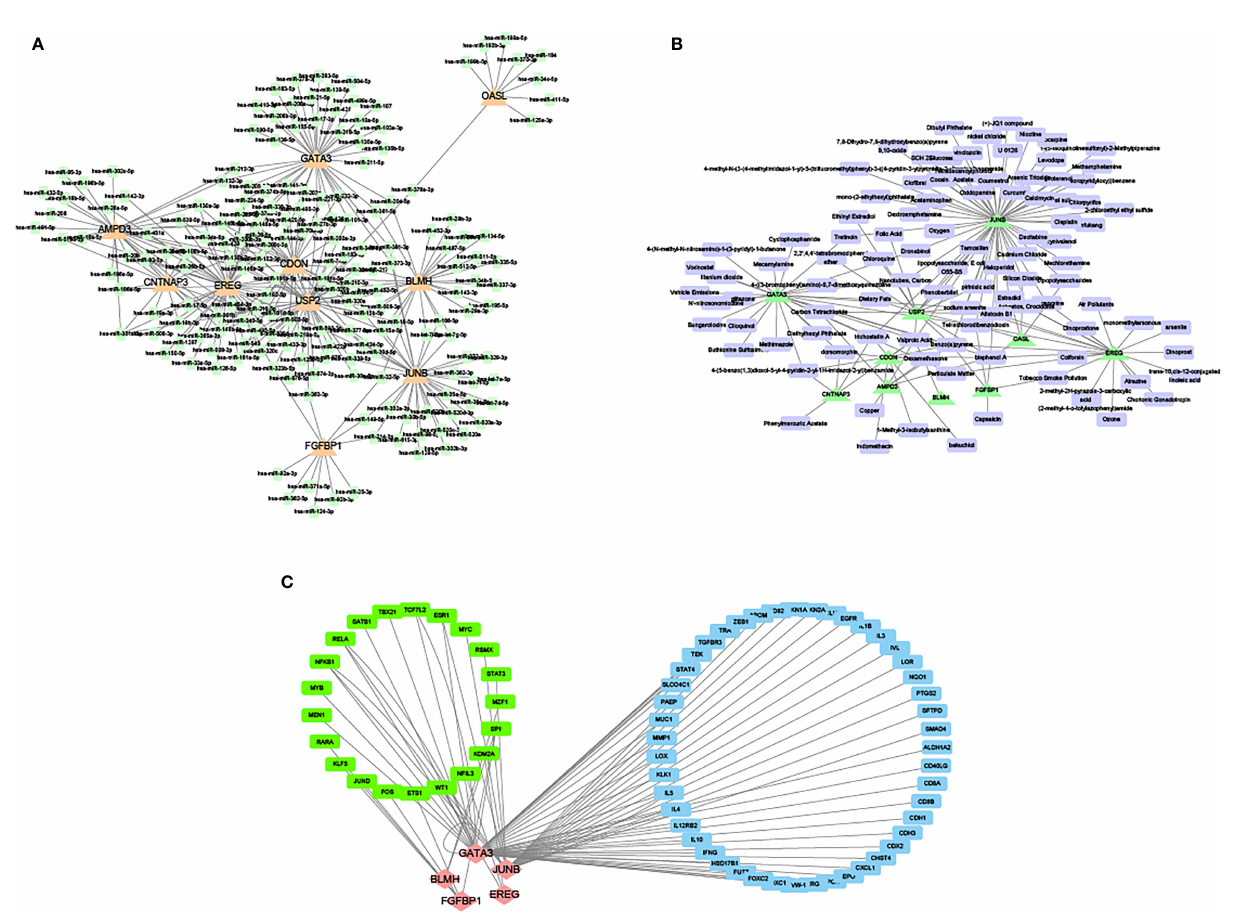
FIGURE 12 | Network of miRNA and mRNA. (A) The network between overlapping mRNA and miRNA. Orange triangles represent overlapping mRNA. Green blocks represent miRNA. (B) The network between overlapping and targeted drugs. Green triangles represent overlapping mRNA. Purple blocks represent targeted drugs. (C) The network between overlapping mRNA and transcription factors. Red rhombuses express mRNA. Green blocks represent transcription factors that regulate mRNA. Blue blocks represent genes that are regulated when mRNA is a transcription